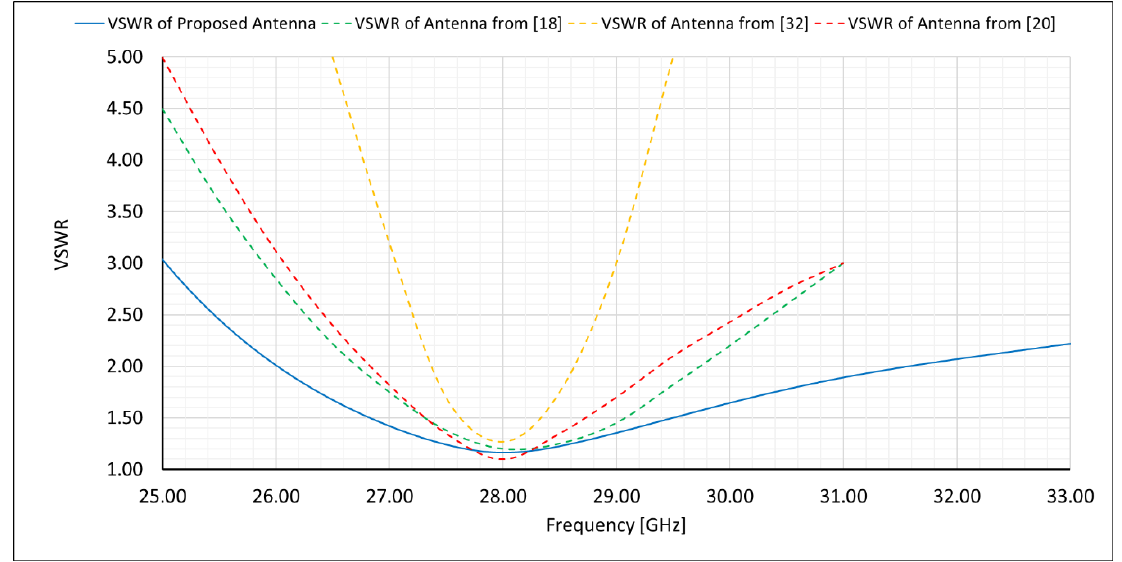
Figure 14. The voltage standing wave ratio (VSWR) as a function of frequency for the proposed antenna, and antennas from other works.